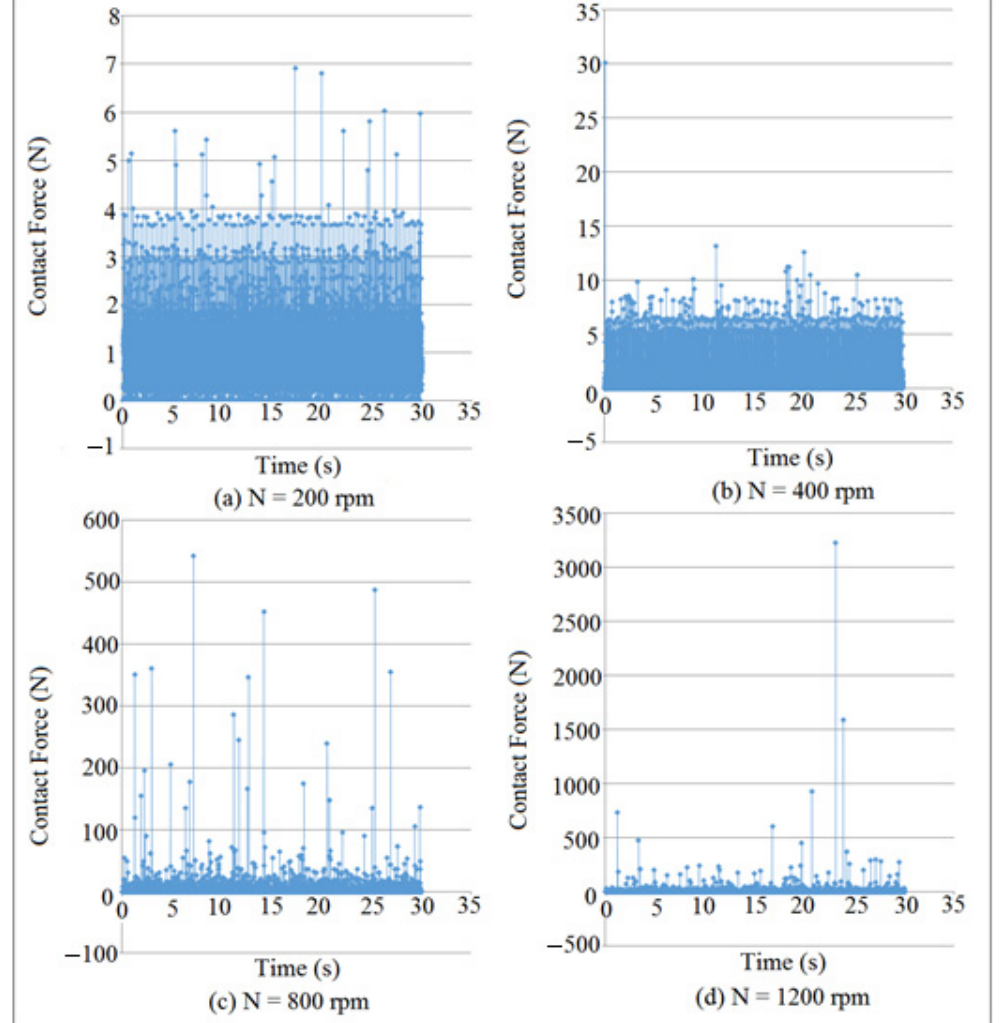
Figure 15. Contact force mapping against time at different cam speeds for (I.D. = 17 mm).